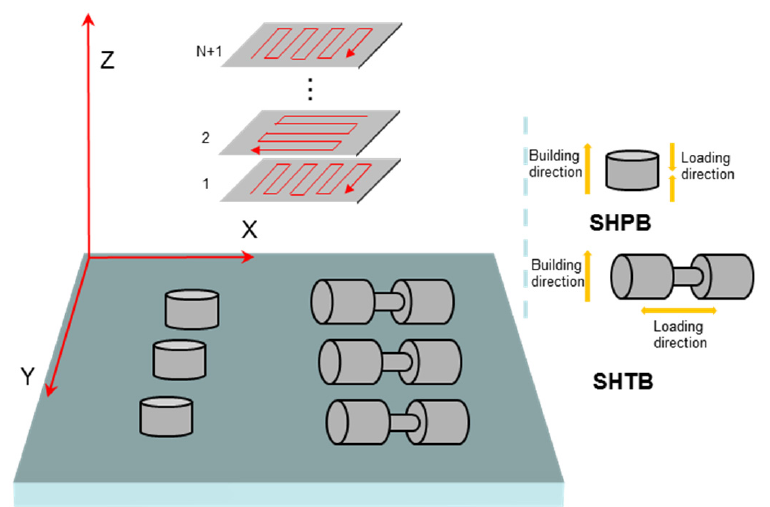
Table 2. SLM process parameters used for specimen fabrication.